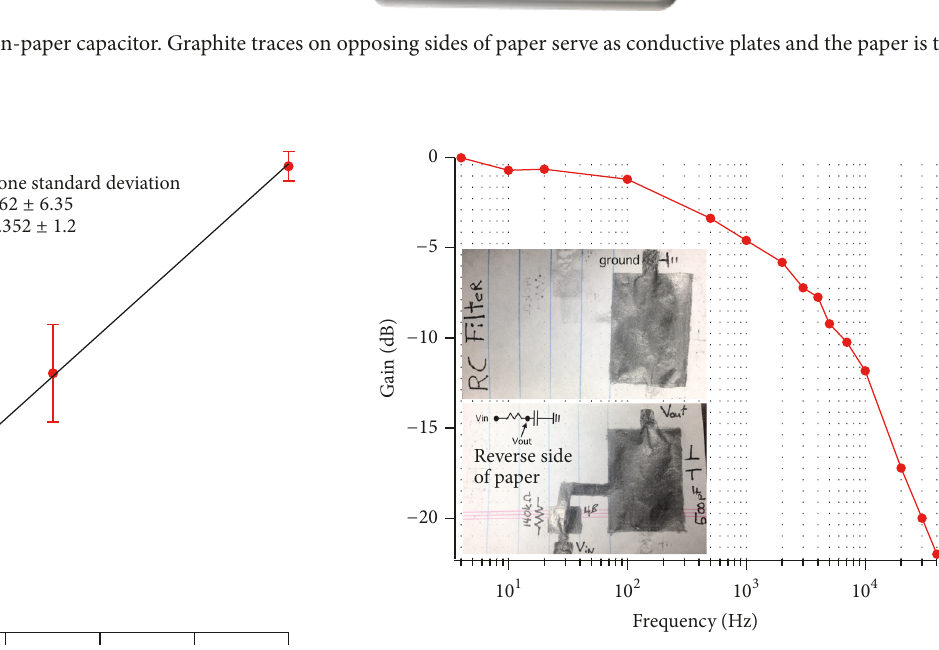
Figure 3: Bode plot for pencil-drawn RC filter. The circuit diagram is illustrated in the photograph. Circuit gain was determined by measuring peak-to-peak voltage ( 𝑉 pp ) of a sine wave of stated frequency at circuit output for constant magnitude